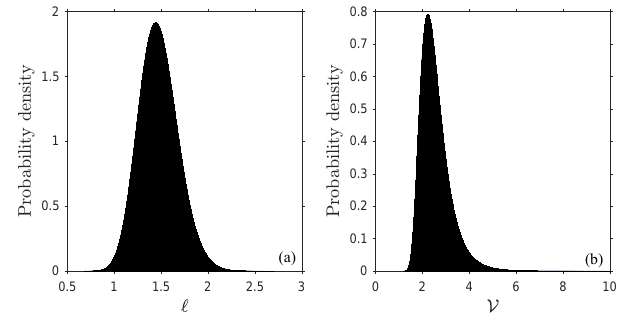
Figure 4. Empirical distribution of (cid:96) and the corresponding U . The example refers to ˆ α = 1 . 50, N = 50, λT =